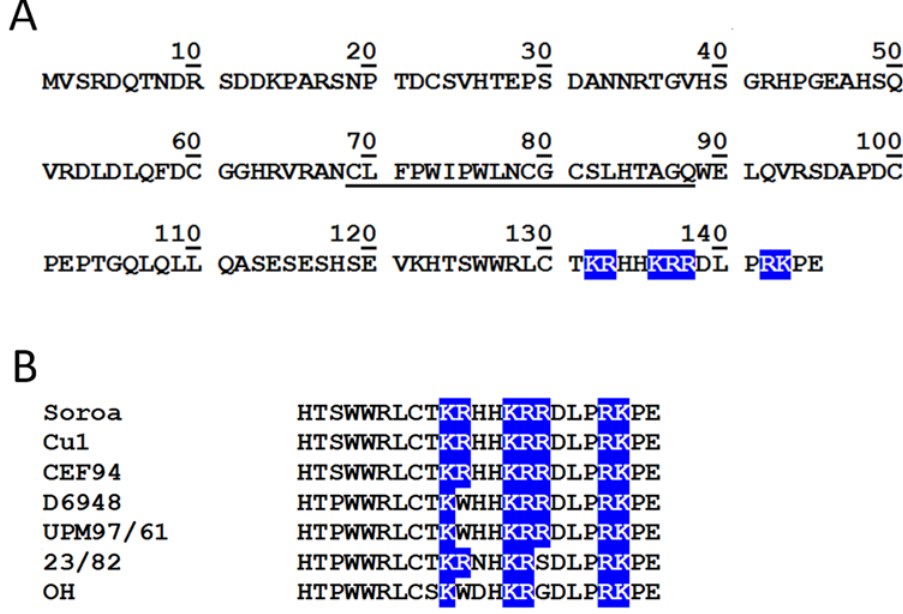
Fig 1. VP5 amino acid sequence. A. Deduced VP5 sequence corresponding to the IBDV Soroa strain. Positively charged amino acid residues at the C-terminal are highlighted in blue. Residues corresponding to the putative transmembrane domain are underlined. B. Multiple sequence alignment of the 23 VP5 C- terminal residues from classical virulent serotype I Soroa, CEF94 (accession number: AF194428), and Cu1 (D00867); very virulent serotype I D6948 (AF240686) and UPM97/61 (AF247006); and avirulent serotype II 23/82 (AF362773) and OH (IBU30818) strains. Conserved electropositive residues are highlighted in blue.